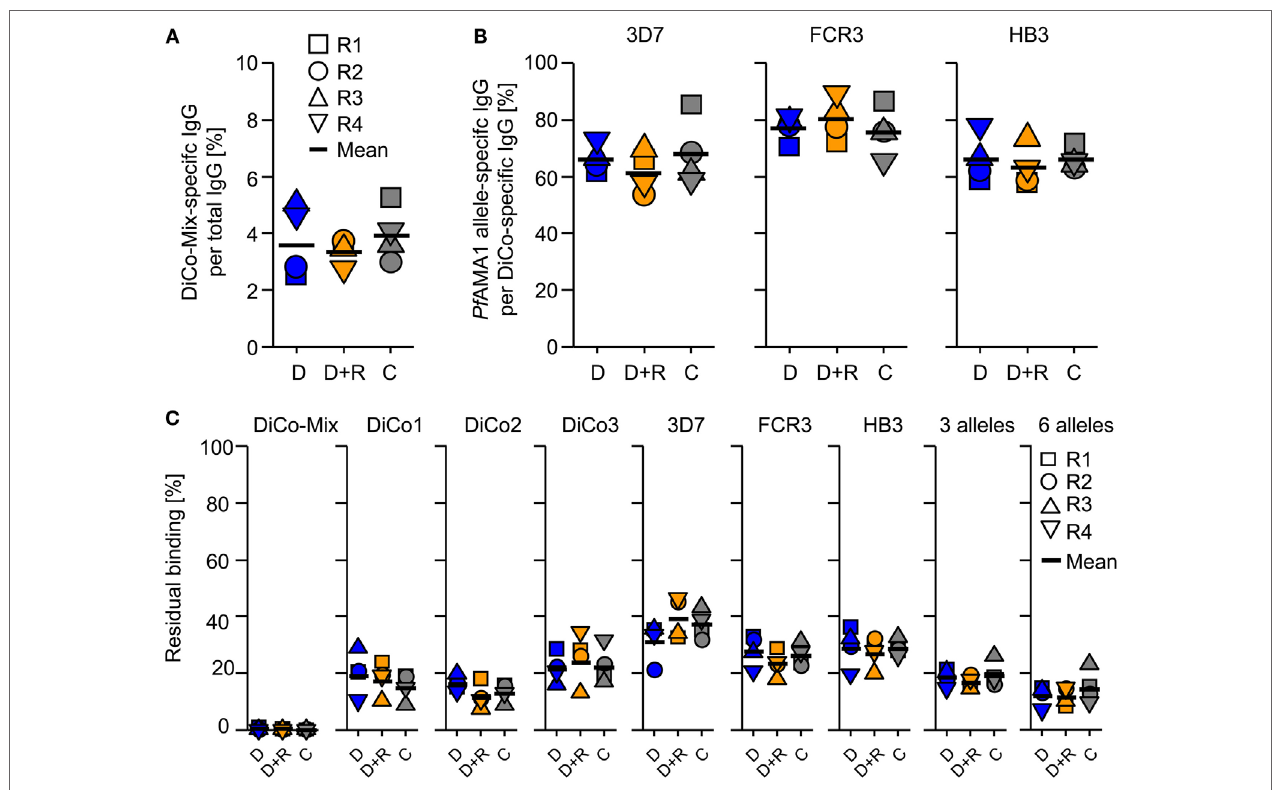
FigUre 4 | Quantification and analysis of purified immune IgG. The total IgG concentration in the purified IgG preparation was determined by analytical size exclusion chromatography. The antigen-specific IgG concentration for the immunization antigen (DiCo-Mix) as well as for three Plasmodium falciparum apical membrane antigen 1 ( Pf AMA1) alleles (3D7, FCR3, and HB3) was quantified by surface plasmon resonance (SPR) spectroscopy (Biacore T200) using the calibration-free concentration analysis (CFCA) module. The DiCo-specific IgG concentration is expressed as a percentage of total IgG (a) and as an indication for balanced Pf